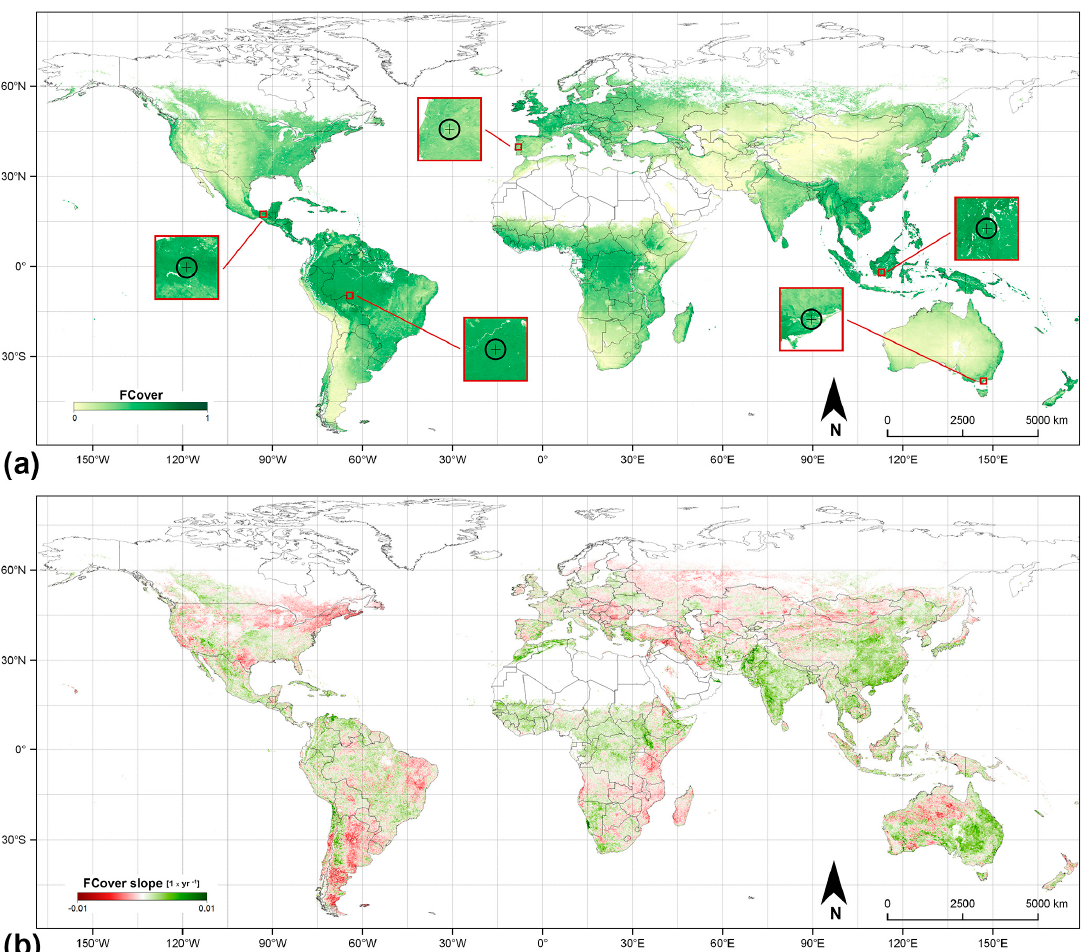
Figure 4. Over the period of 2001–2015 ( a ) Average of global FCover product and site locations of the break detection analysis (bounding boxes); ( b ) global FCover temporal trend slope: percentage increase (green) and decrease (red) are shown as annual rates.